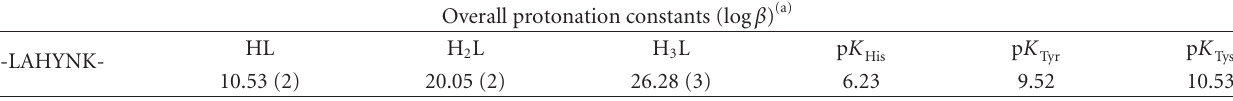
Table 2: Stability and ionization constants of the peptide